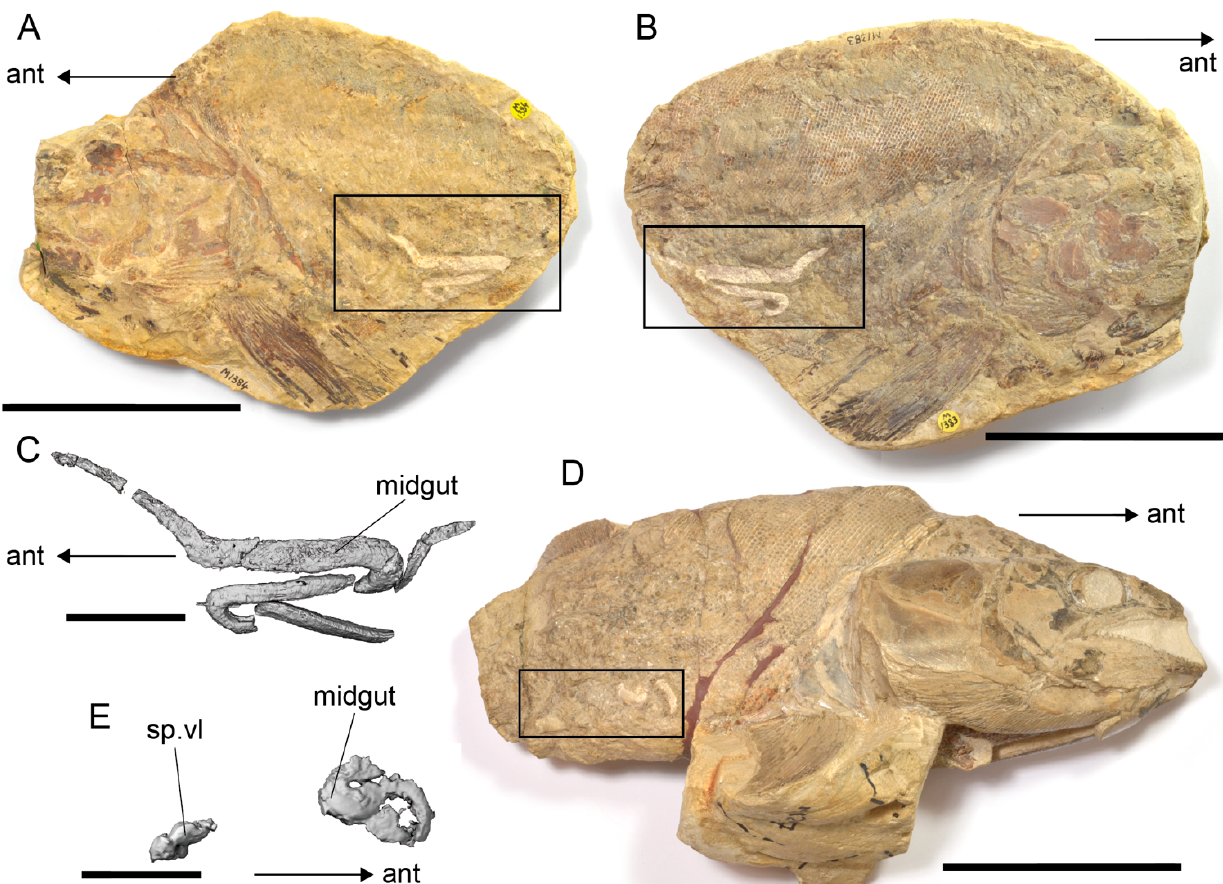
Figure 11. Alimentary canal in Pachycormus spp.: ( A ) Exposed midgut of Pachycormus in part (BRLSI.1384) and ( B ) counterpart (BRLSI.1383). ( C ) Three ‐ dimensional render of the midgut with preserved regions of the alimentary tract in both part and counterpart combined. Note that some portions are entirely buried within the matrix and are not visible on the surface of the specimen. ( D ) Exposed midgut of Pachycormus macropterus (BRLSI.1297). ( E ) Three ‐ dimensional render of the midgut and anterior portion of the spiral intestine. This latter feature is not visible on the surface of the specimen. The rectangular boxes in ( A , B , D ) indicate the extent of the preserved alimentary canal shown in the corresponding renders. sp.vl, Spiral valve. Scale bars = 50 ( A , B , D ); 25 mm ( C , E ). Photographs courtesy of Matt Williams (BRLSI).